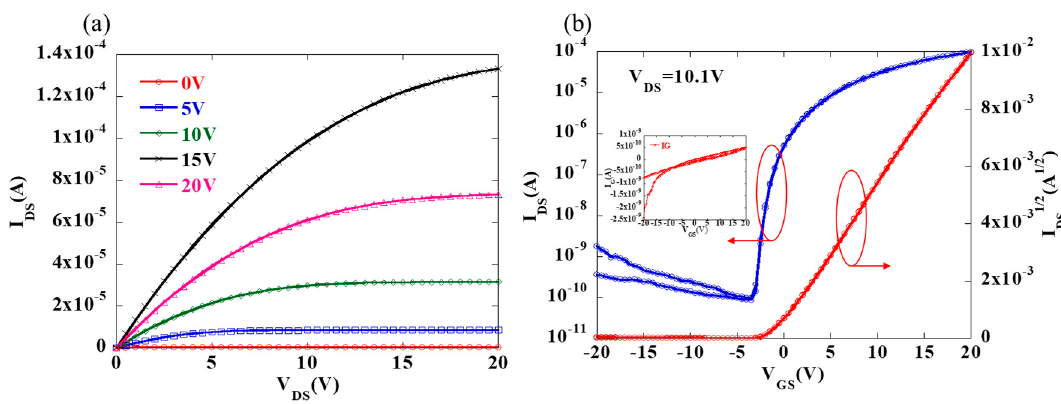
Figure 2. ( a ) Output characteristic curves (I DS ‐ V DS ) and ( b ) transfer characteristic curve (I DS ‐ V GS ) of manufactured coplanar top ‐ gate Nd ‐ IZO TFTs. V GS is varied from − 20 to 20 V with V DS = 10.1 V, and the inset was the gate leakage current.